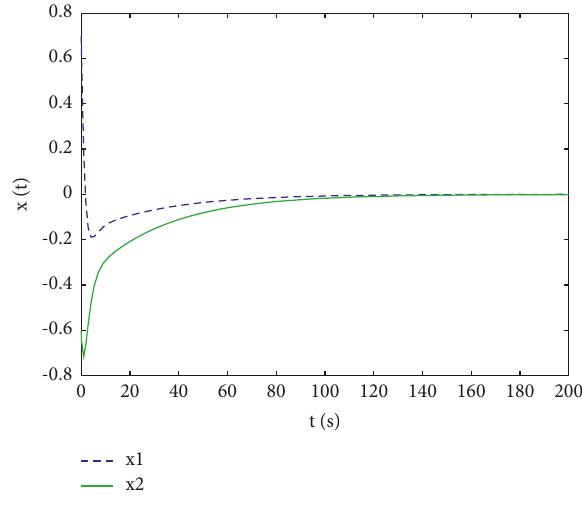
Figure 1: The trajectories of x ( t